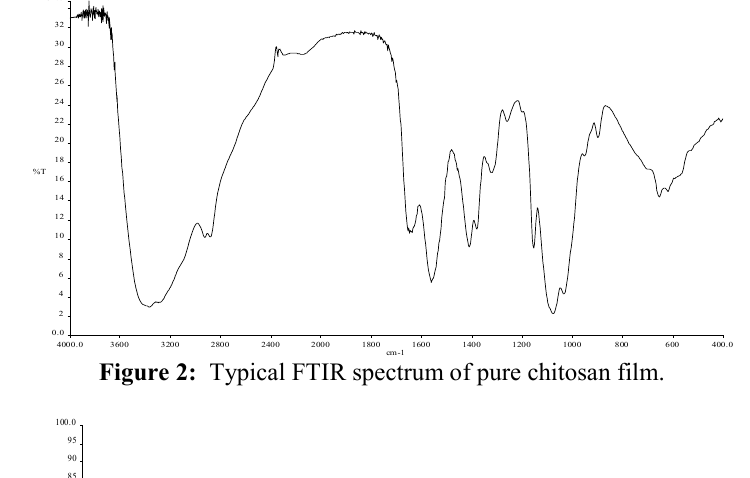
Figure 2: Typical FTIR spectrum of pure chitosan film.